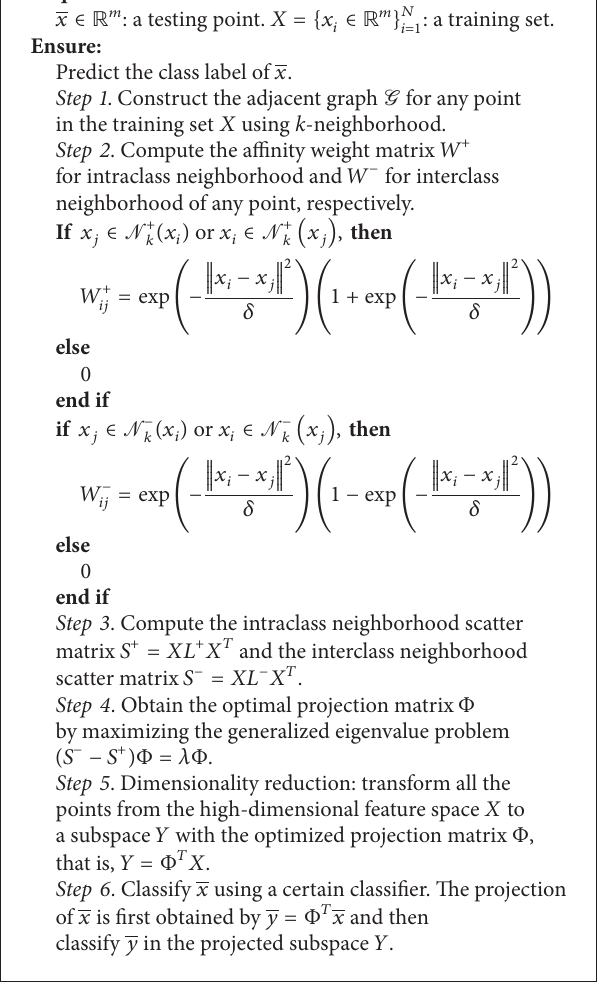
Algorithm 1: Maximum neighborhood margin discriminant pro- jection.